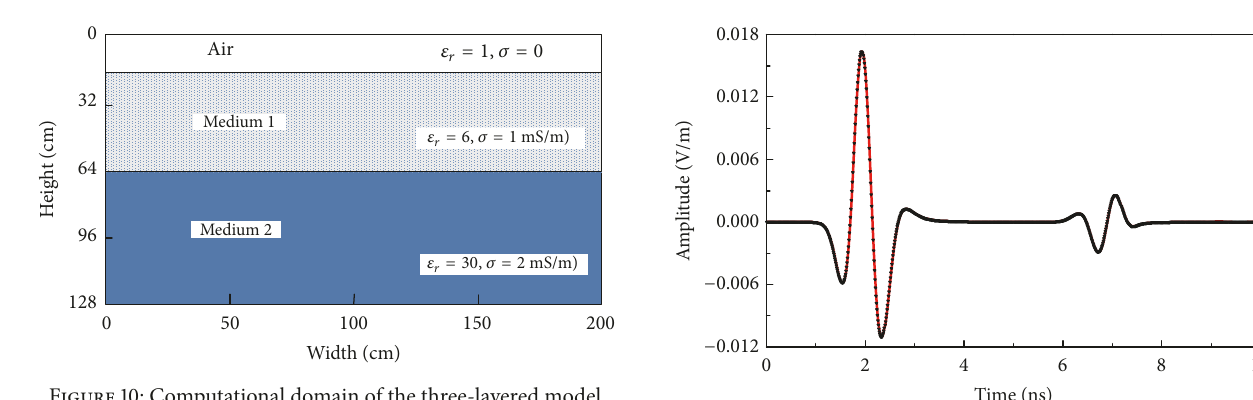
Figure 10: Computational domain of the three-layered model.